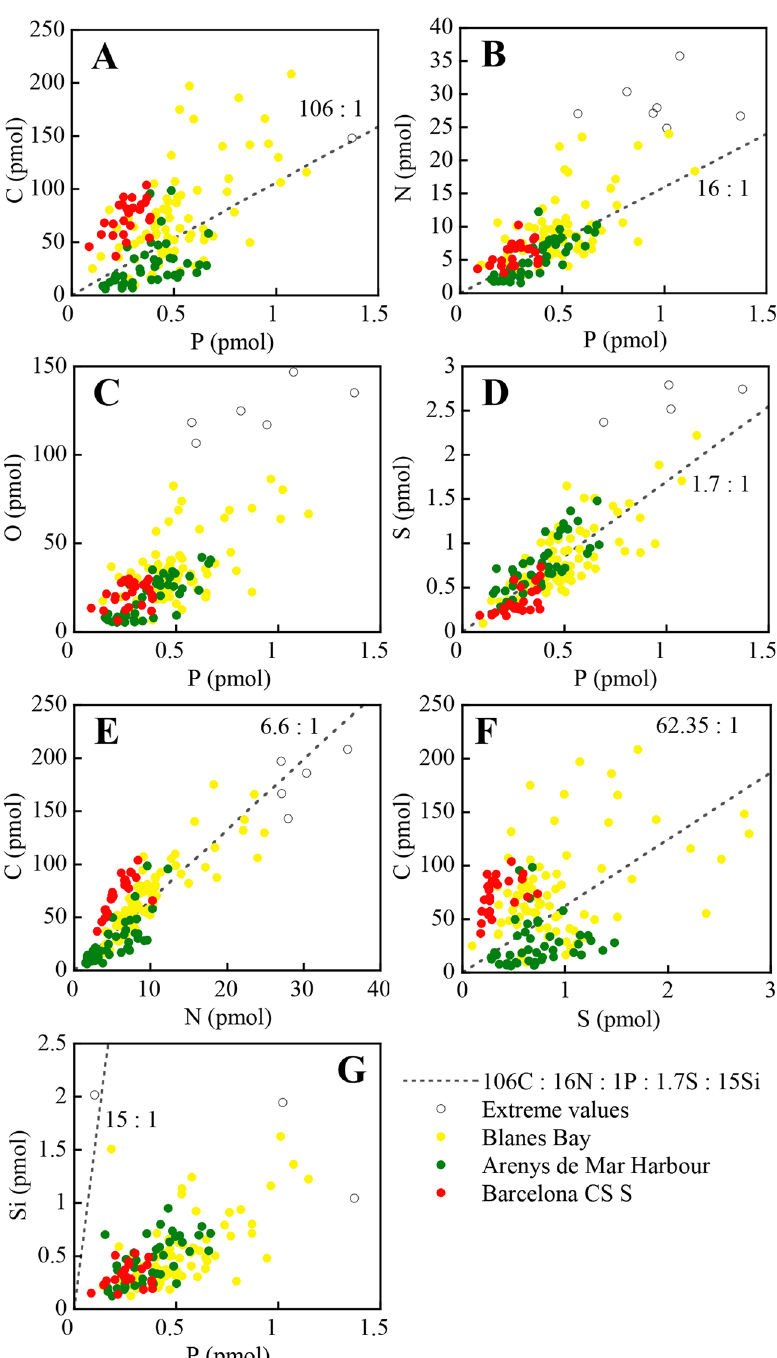
Fig 4. Molar relationships between C, N, O and S vs . P, C vs . N and S, and Si vs . P of individual dinoflagellates from the NW Catalan Sea. Cells from the same location are plotted with the same colour. Note that axes